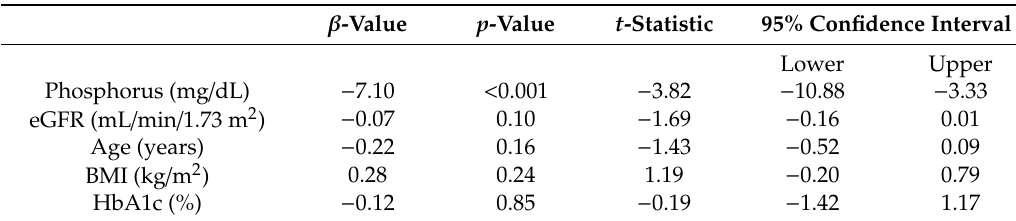
Table 4. Multiple linear regression analysis using grip strength as the dependent